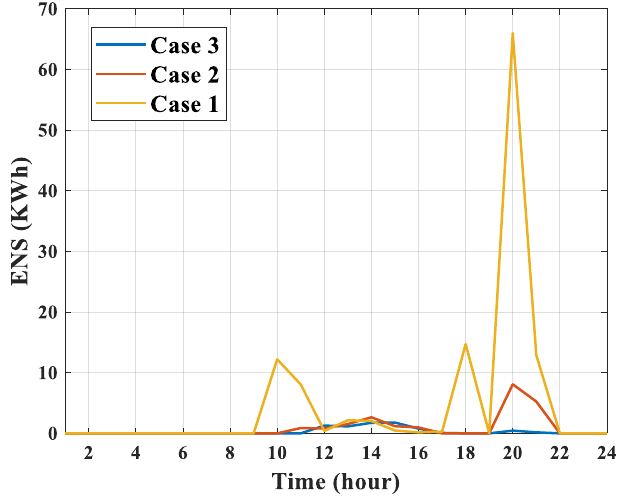
Figure 5. ENS of electrical load.